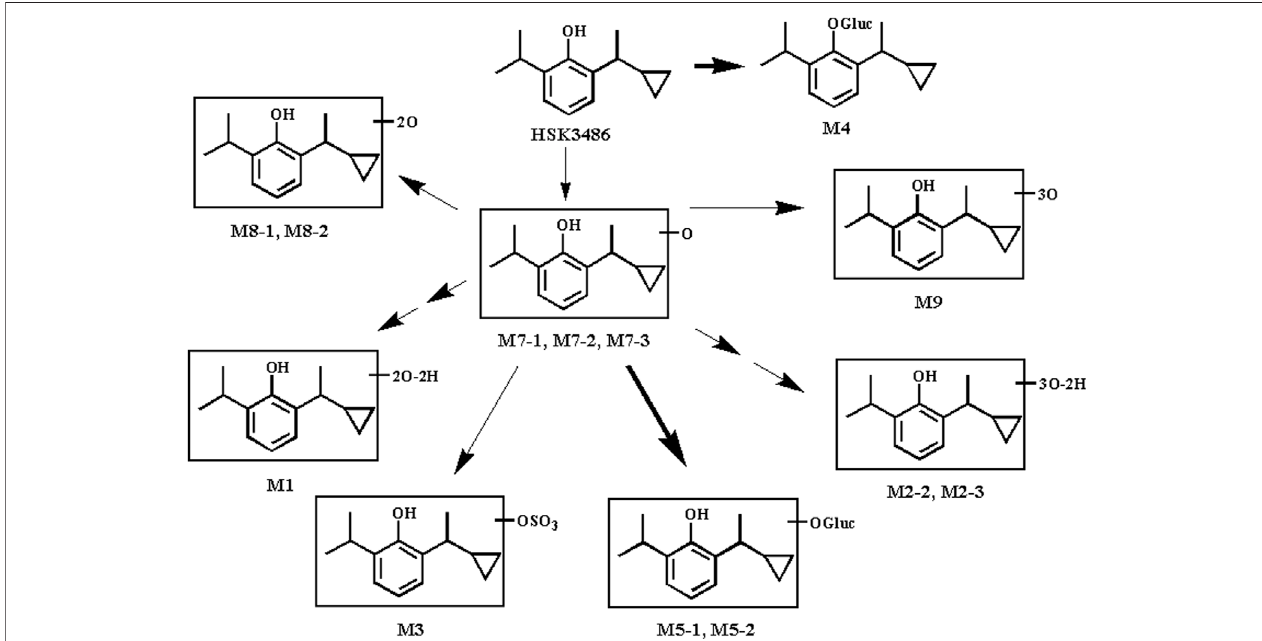
FIGURE 7 | Proposed pathway of HSK3486 metabolism in microsomes or S9